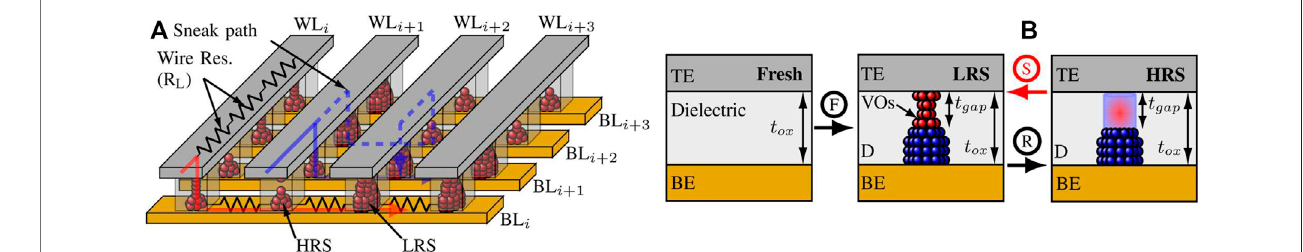
FIGURE 1 | (A) Sketch of the CPA structure. Red and blue arrows exemplify the electron fl ow through the memdiodes connecting the top (Word lines -WL-) and bottom lines (Bit lines -BL-). Different resistance states are schematically represented (High Resistance State -HRS- to Low Resistance State -LRS-). The dashed blue linerepresentstheso-calledsneak-pathproblem.TheparasiticwireresistanceisindicatedforWL i andBL i . (B) SchematicrepresentationoftheMIMstructurewherethe RS mechanism takes place, before the forming step and during the LRS to HRS alternate transition. Blue and red balls indicate metallic ions and/or oxygen vacancies